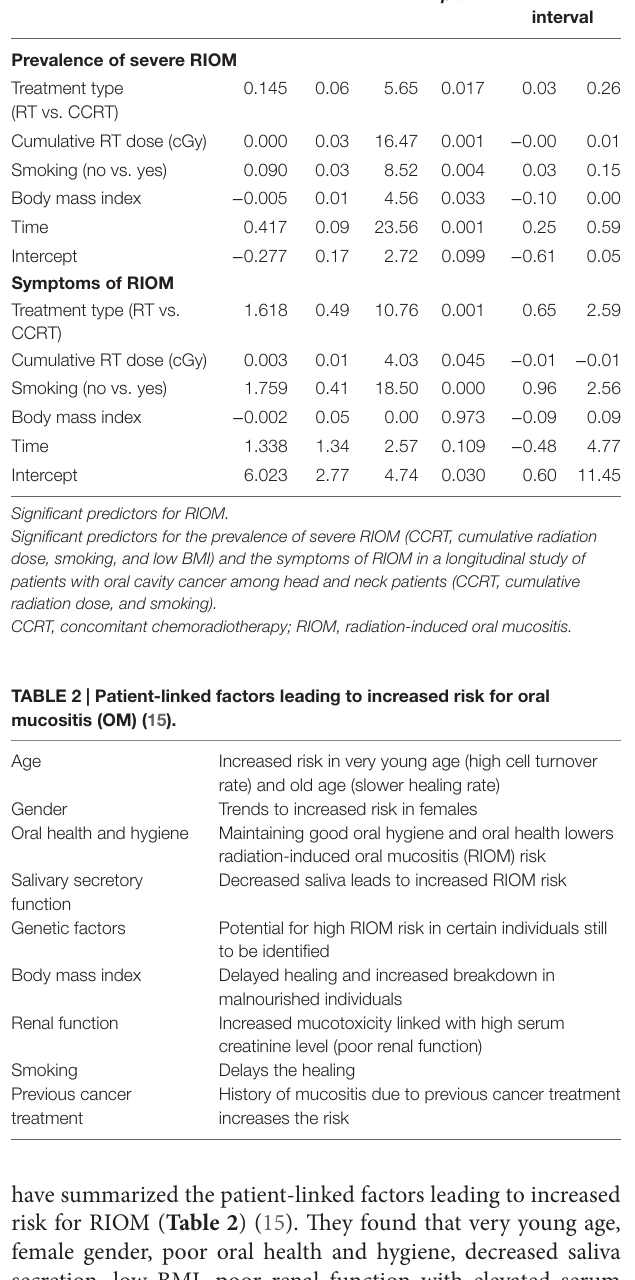
TAbLe 1 | Data analysis for RiOM predictors using ibM SPSS version 21.0 (Armonk, NY, uSA) (14).